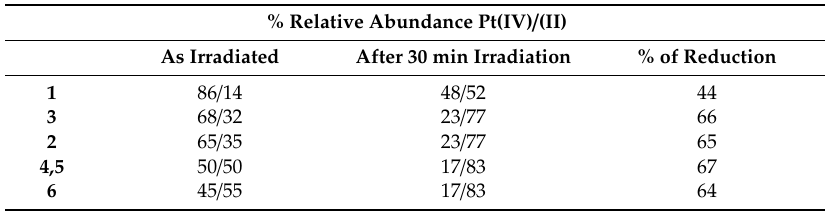
Table 4. Relative abundance of the two Pt oxidation states as derived from XPS analysis at the onset of the experiment and after 30 min irradiation and % of reduction for compounds 1 – 6 . % of reduction